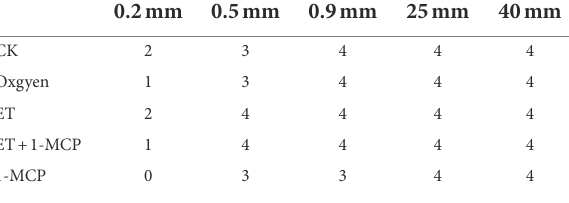
TABLE 1 Ring number on the transverse section of aerenchyma in N. nucifera roots.